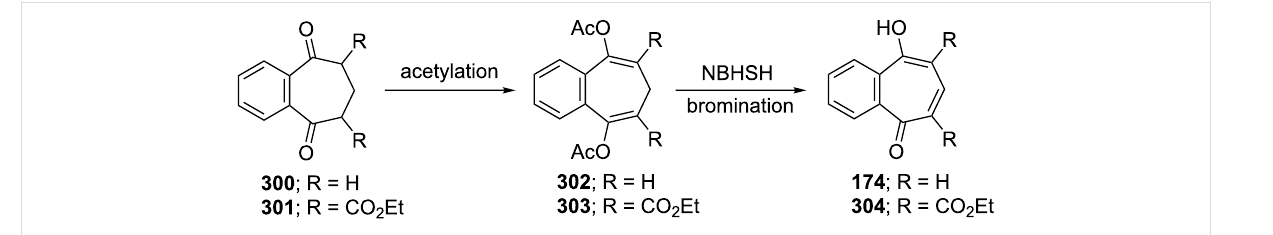
Scheme 50: Synthesis of 4-hydroxy-2,3-benzotropones 174 and 304 from diketones 300 / 301 .